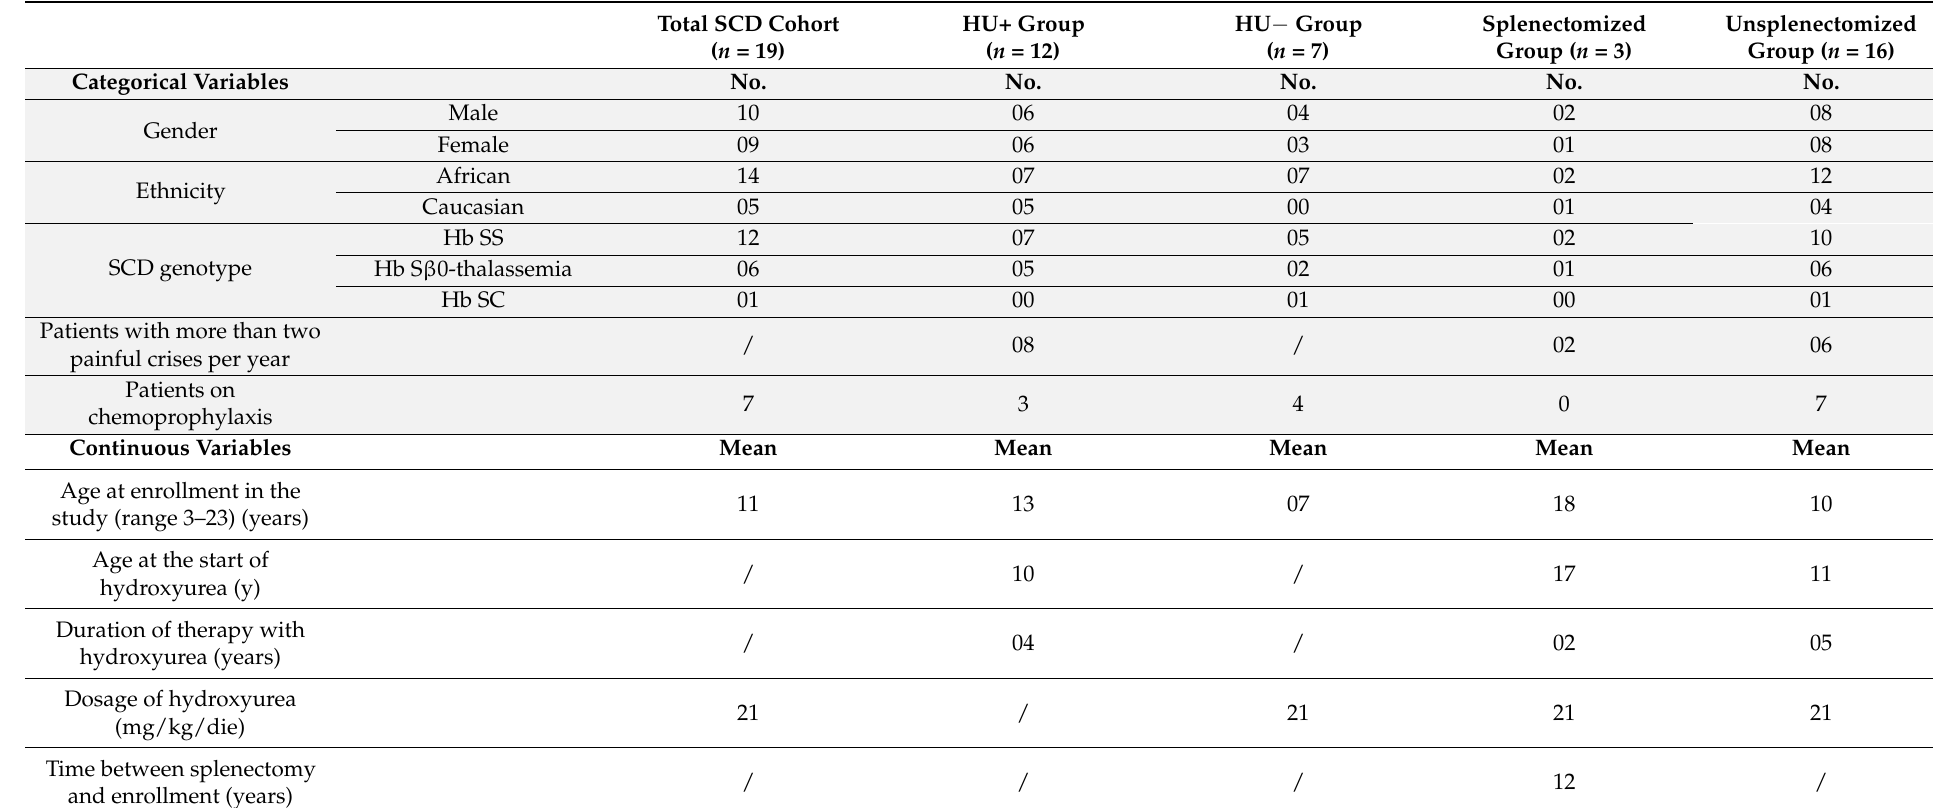
Table 1. General characterization of the SCD cohort, HU+/HU − and splenectomized/unsplenectomized